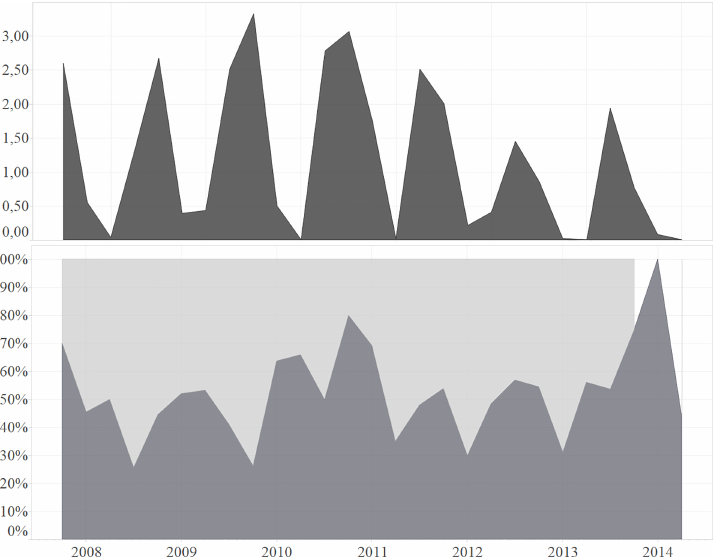
Fig 6. Daily rainfall (upper panel in mm) and percentage of male conceptions (lower panel in %) over